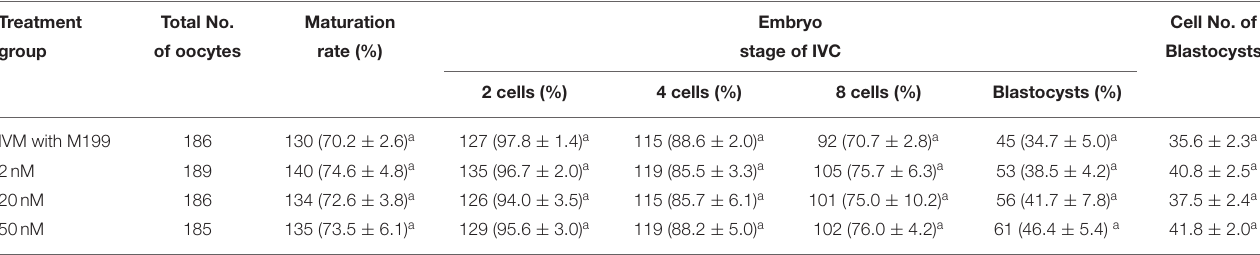
TABLE 5 | Effects of IVM media supplemented with miR-148a-3p on the development of parthenogenetic activation porcine embryos. Treatment Total